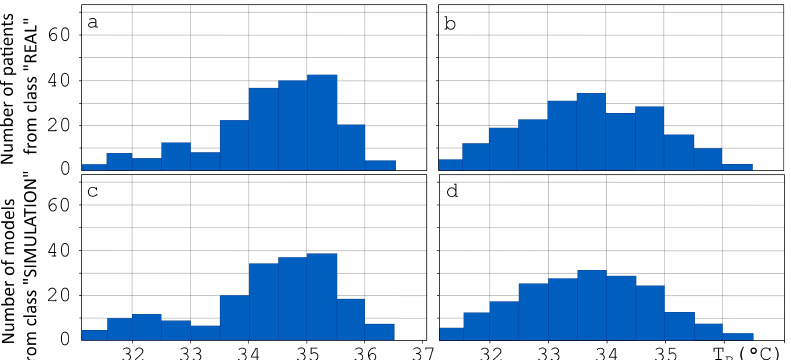
Figure 13. Distributions of internal temperature values at point “0” according to the following classes: “Healthy” according to medical examinations (“REAL”) ( a ); dataset “REAL” if diagnosed with cancer ( b ); “Healthy” according to the results of computational experiments (dataset “SIMULA- TION”) ( c ); “Cancer” by dataset “SIMULATION” ( d ).